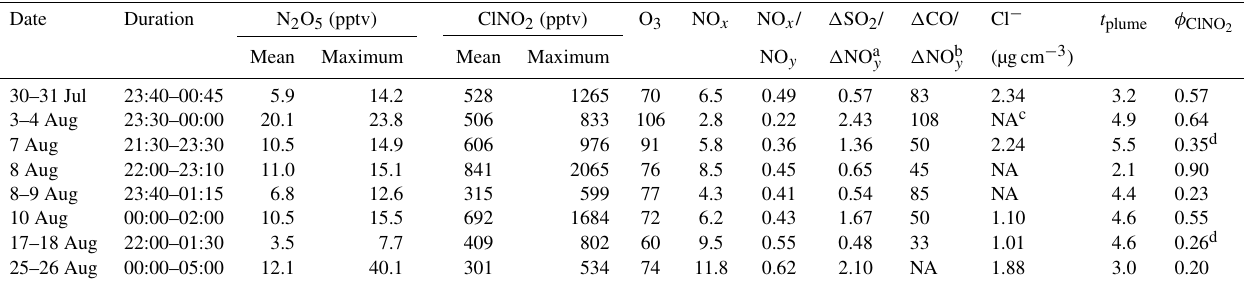
Table 1. Chemical characteristics of coal-fired power plant and industrial plumes exhibiting high levels of ClNO 2 observed at Mt. Tai during the summer of 2014.